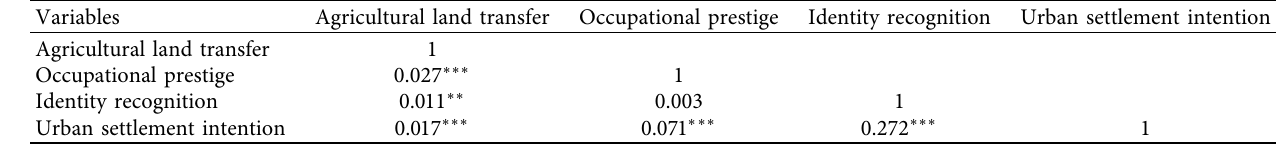
Table 2: Correlation analysis.